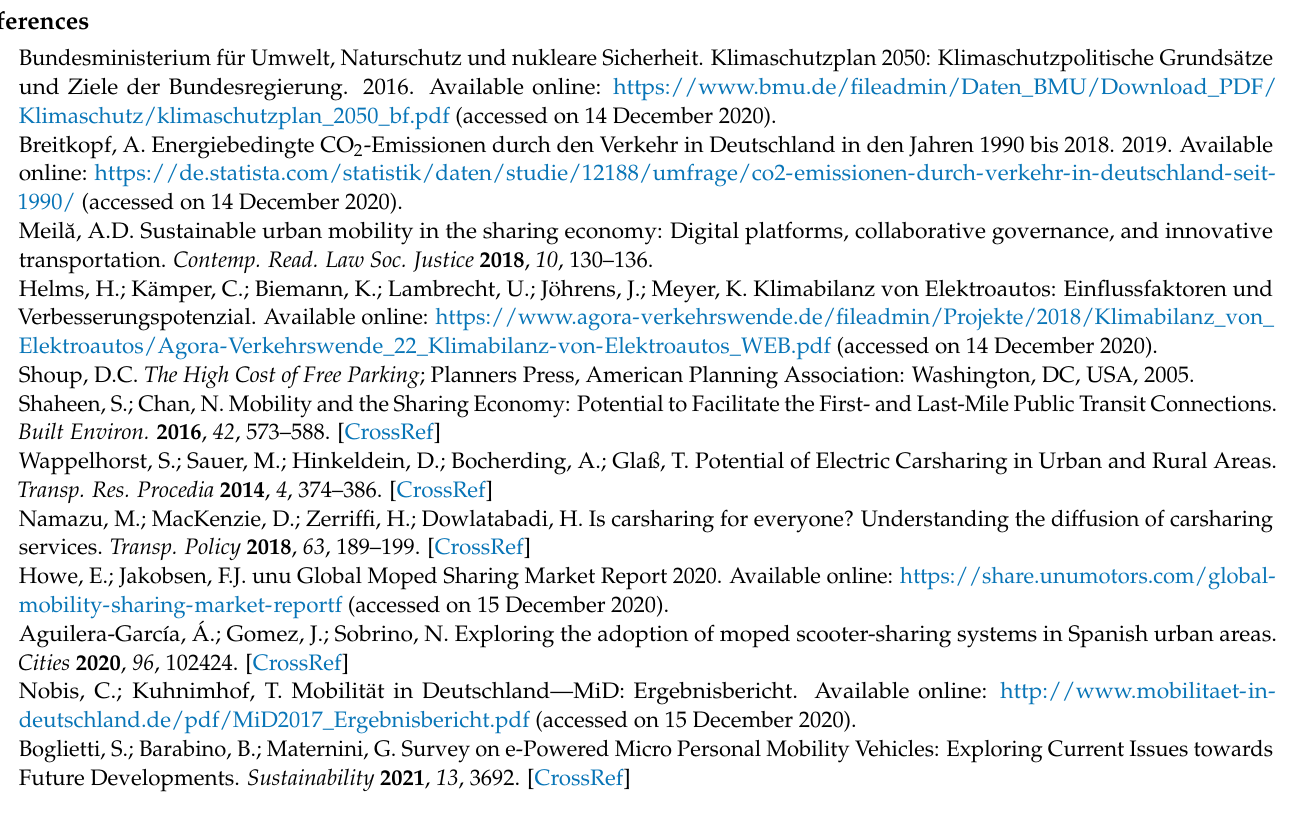
Table S2: LCIA for e-moped fleets with renewable electricity mix; Table S3: CED for e-moped fleets with German electricity mix of 2019; Table S4: CED for e-moped fleets with renewable electricity mix; Table S5: Personnel cost structure for e-moped fleets for main scenarios; Table S6: Personnel cost structure for e-moped fleets for additional scenarios (PF—personal factor, BS—8 h battery swap); Table S7: Cross-scenario operation parameters for e-moped fleets; Table S8: Scenario-specific operation parameters for e-moped fleets for main scenarios; Table S9: Scenario-specific